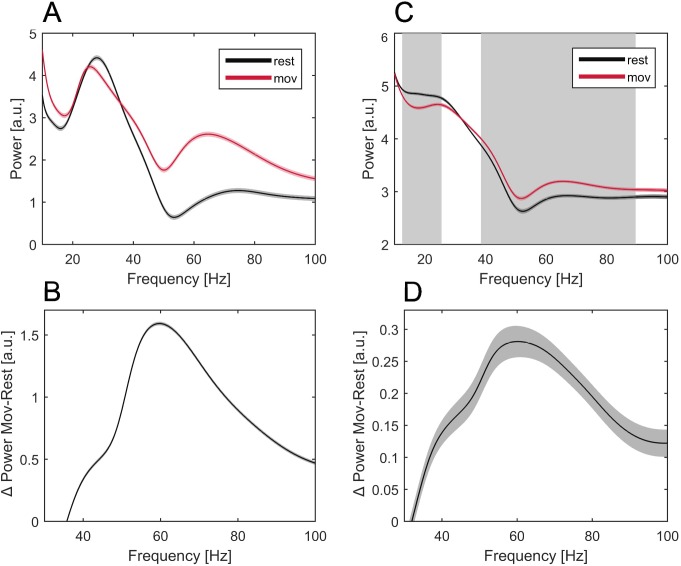
Averaged power spectra at rest and movement in an exemplary patient and across all patients.Power spectra averaged across all trials over rest (−2 to −1.5 s before MO, black line) and movement time (0–0.5 s after MO, red line) of a single exemplary patient (A) and across all patients (C). Frequencies that show significant power change during movement across patients are labeled (C, grey background). The absolute difference of power in each frequency bin between rest and movement time is shown for the single patient (B) and across patients (D, grey shading = SEM). Note the narrow peak in gamma power increase during movement (A–D).